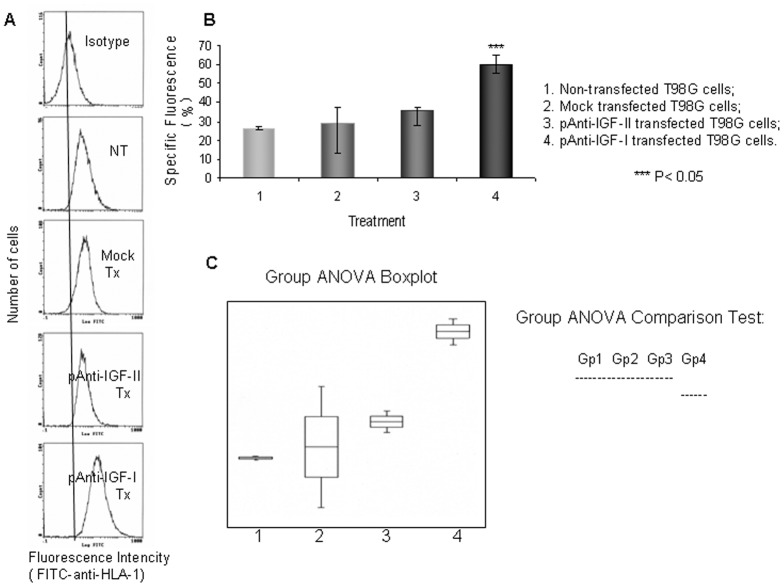
Comparison of HLA-1 cell surface antigens in pAnti IGF-1 transfected, mock transfected, pAnti IGF-2 transfected and non-transfected T98G cells.A, Histogram of fluorescence intensity from isotype control (non-transfected cells+mouse IgG FITC); NT (non-transfected cells+mouse anti-human HLA-1 mAb+goat anti-mouse IgG FITC); Mock TX (cells transfected with vector devoid of anti IGF-1 cDNA+mouse anti-human HLA-1 mAb+goat anti-mouse IgG FITC); pAnti IGF-2 TX (cell transfected with vector expressing IGF-2 RNA in antisense orientation+mouse anti-human HLA-1 mAb+goat anti-mouse IgG FITC); and, pAnti IGF-1 TX (cells transfected with vector pAnti IGF-1+mouse anti-human HLA-1 mAb+goat anti-mouse IgG FITC). B, Specific fluorescence showing differential expression of HLA-1 from pAnti IGF-1 transfected cells when compared to parental non-transfected cells and other controls (P <0.05). C, Group ANOVA comparison was done by boxplot with Newman-Keuls graphical representation for comparison in expression of HLA-1 in the experimental groups. The data in Fig 3 B was repeated×3.